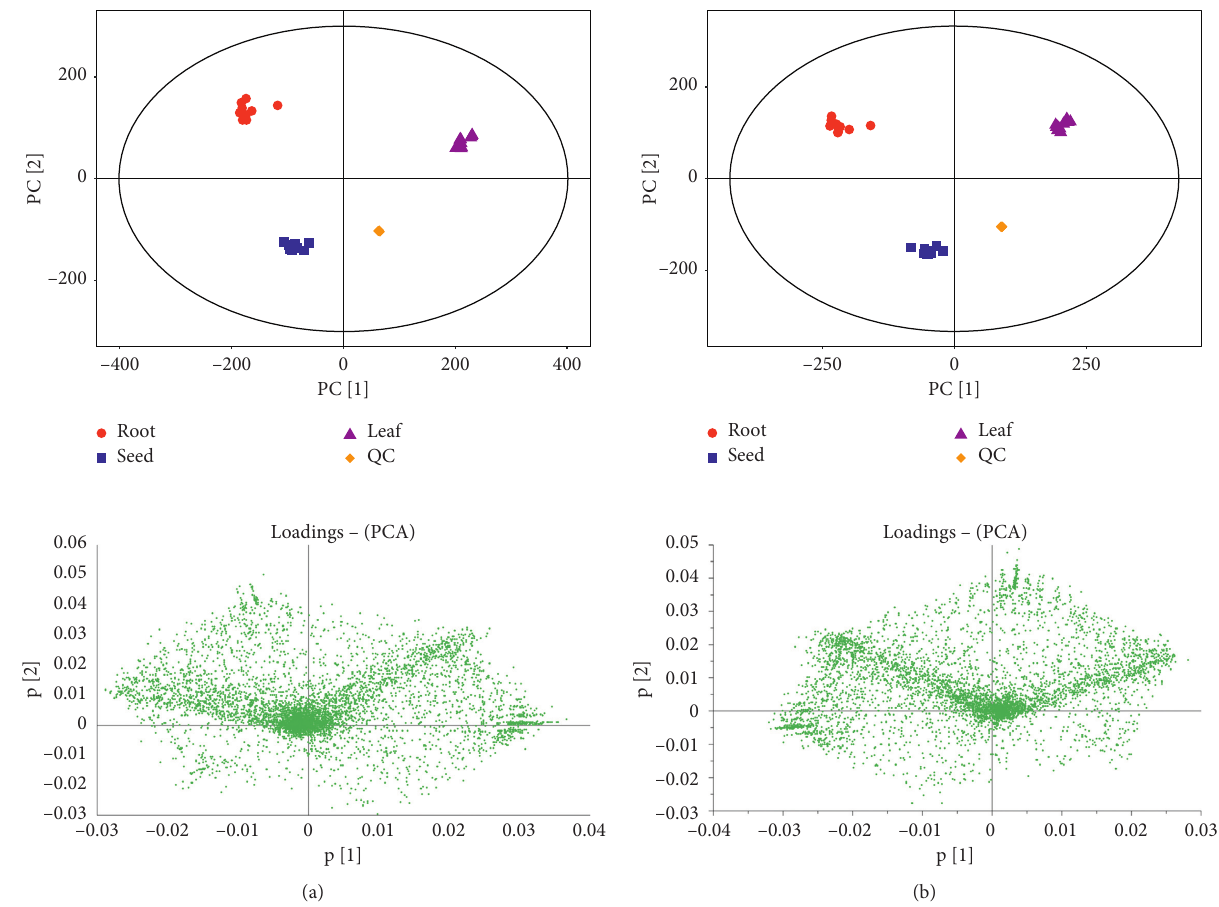
Figure 1: PCA score and PCA loadings ((a) positive ion mode; (b) negative ion